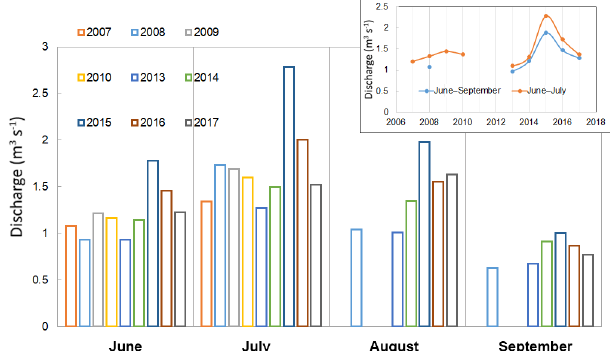
Figure 5. Fluctuations of mean monthly and mean seasonal runoff of Djankuat River during the whole period of observation (2007–